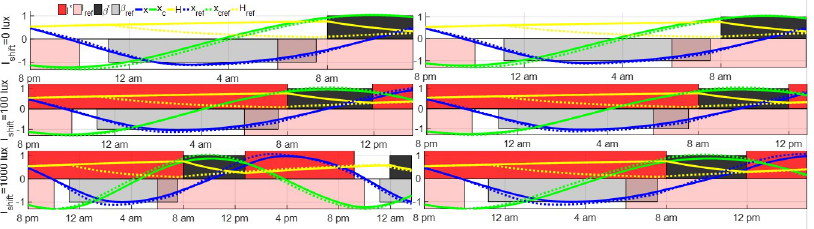
Fig 14. Minimum-time optimal entrainment with controllable sleep schedule and different night shift light intensity I shift , with maximum entrainment light intensity I max = 1000 lux (left) or I max = 10000 lux (right). The minimum entrainment time of these cases is given as 3.46 hours for I shift = 0 lux and I max = 1000 lux, 5.80 hours for I shift = 100 lux and I max = 1000 lux, 17.62 hours for I shift = 1000 lux and I max = 1000 lux, 3.46 hours for I shift = 0 lux and I